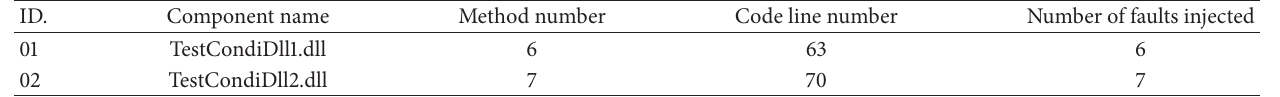
Table 3: The information of two tested component.